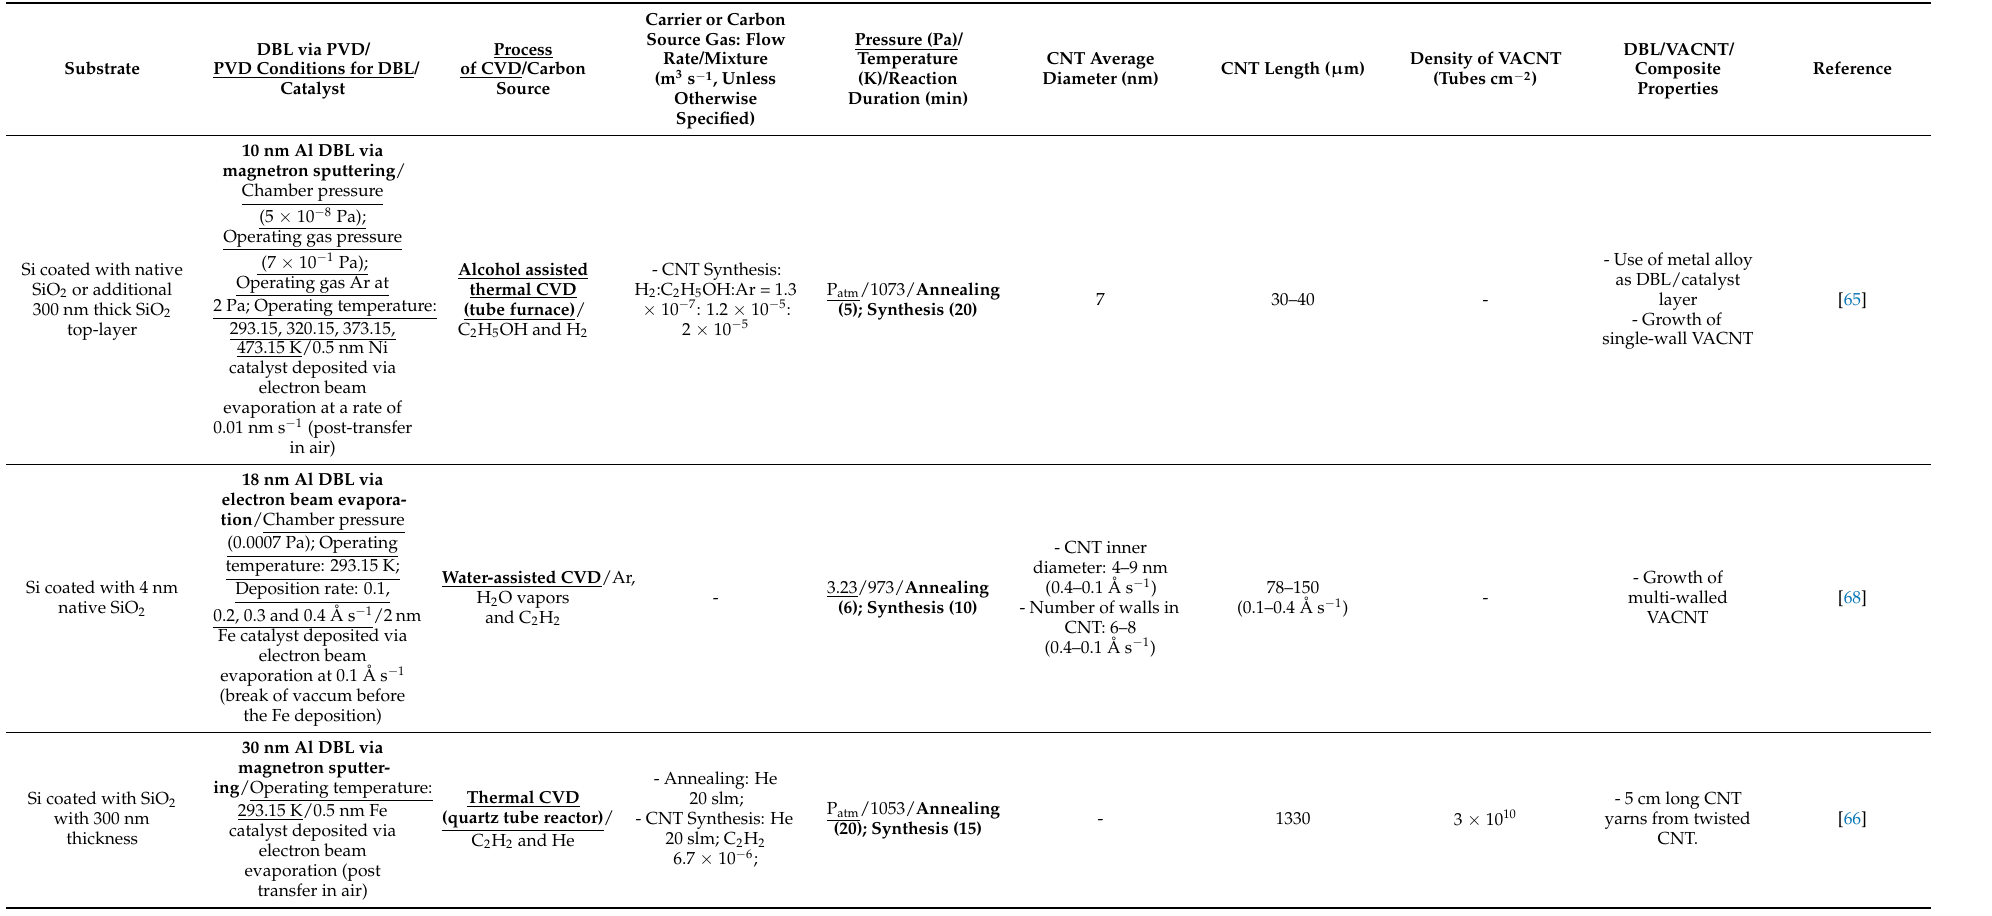
Table 1. Details of used substrate, lone Al DBL (deposited via PVD), and VACNT growth conditions and